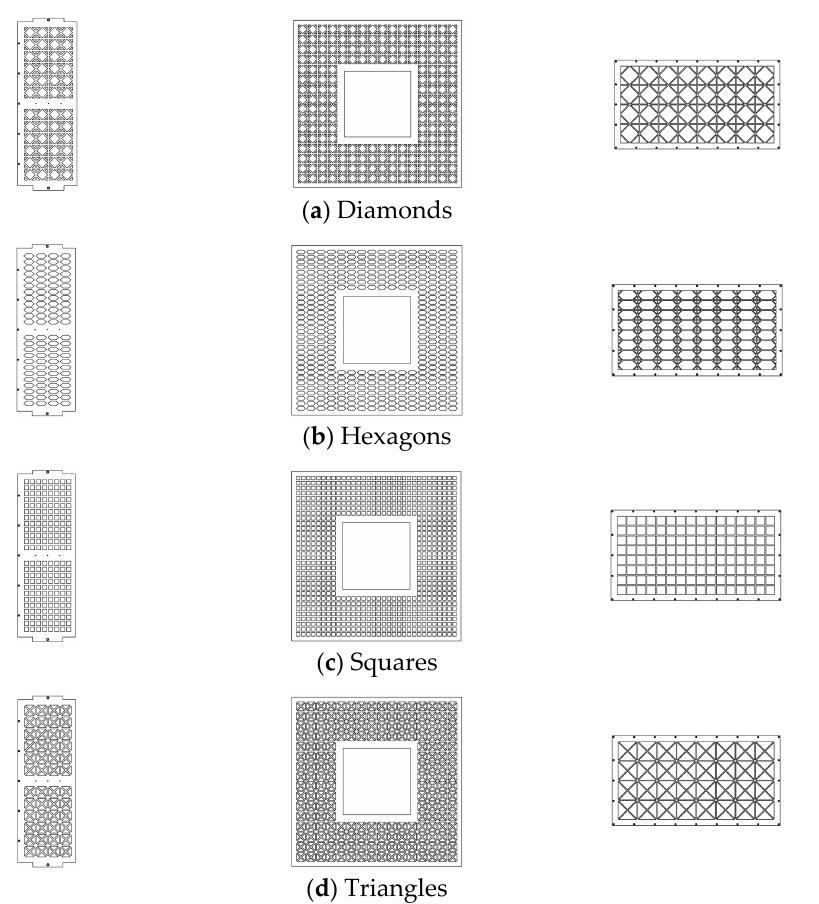
Figure 4. The three perforated structural components after implementation of the patterns.